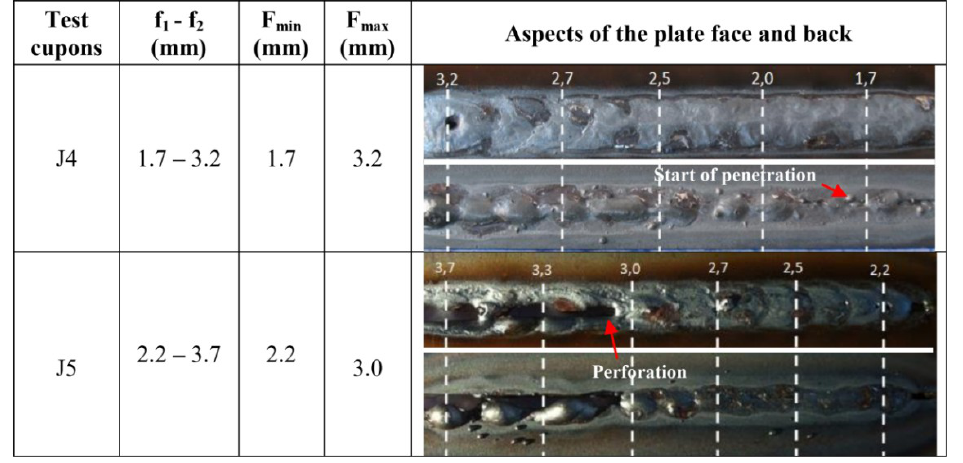
Figure 4. Quantification of the operational gap range for the experiment 1SB (switchback torch movement).